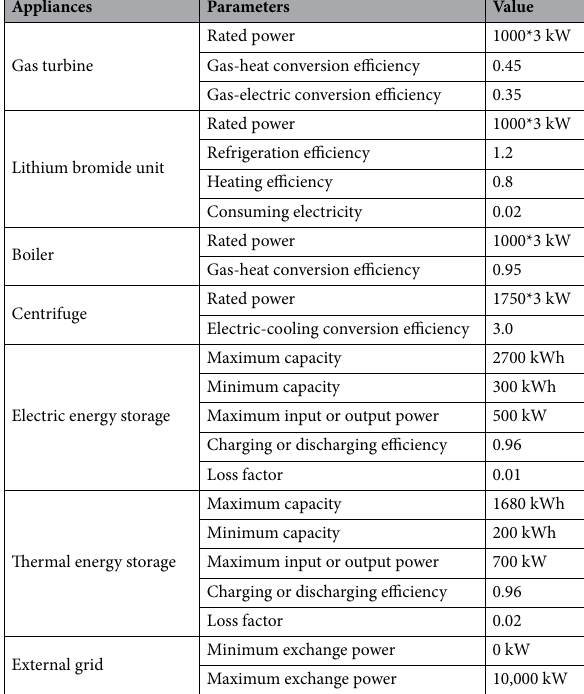
Table 2. The parameters of energy conversion appliances.